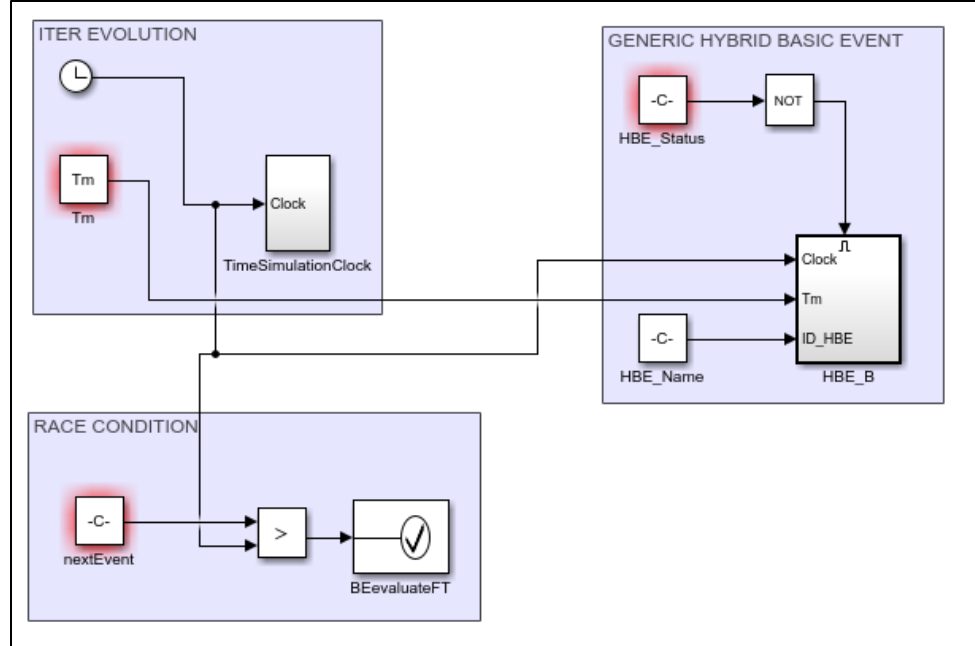
Figure A3. Simulink blocks of the SHyFTA_TEMPLATE.slx file, to use in the Simulink model of a SHyFTA.